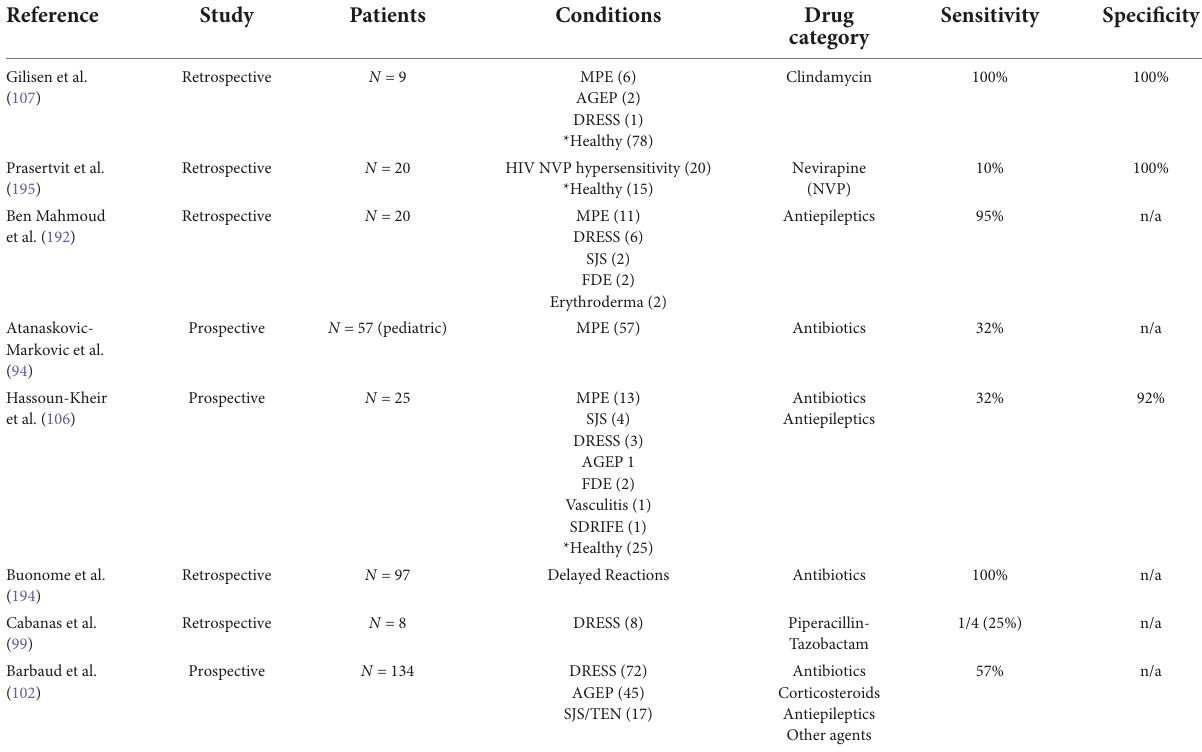
TABLE 3 Recent reported sensitivity and specificity for patch testing in drug